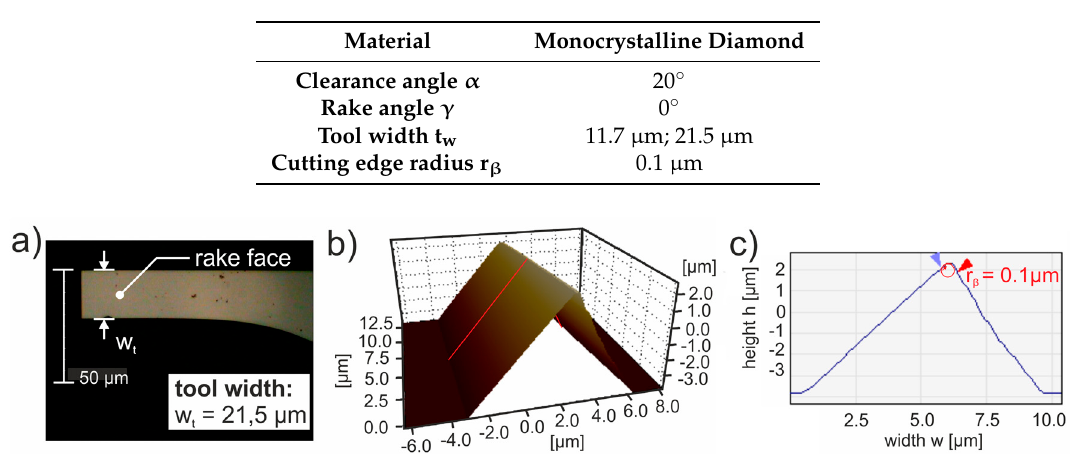
Figure 3. ( a ) Measurement of the diamond tool with a light microscope (magnification 1000×); ( b ) measurement of the tool tip with an atomic force microscope; ( c ) cross section of the tool tip measurement with evaluation of the cutting edge radius.